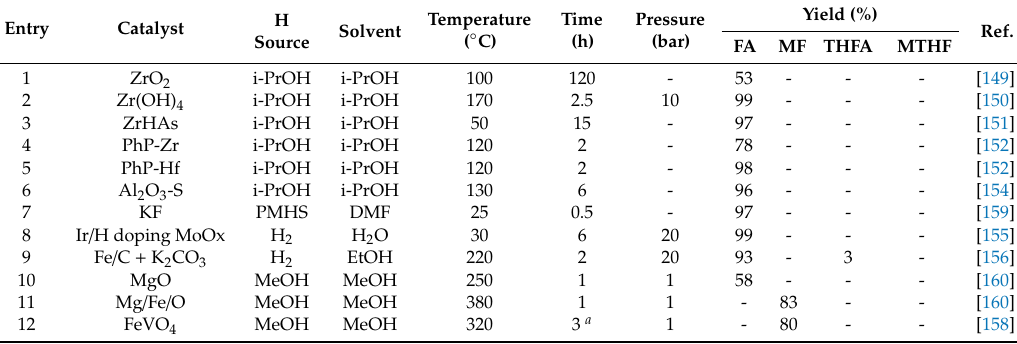
Table 3. Furfural hydrogenation over Zr-based and other